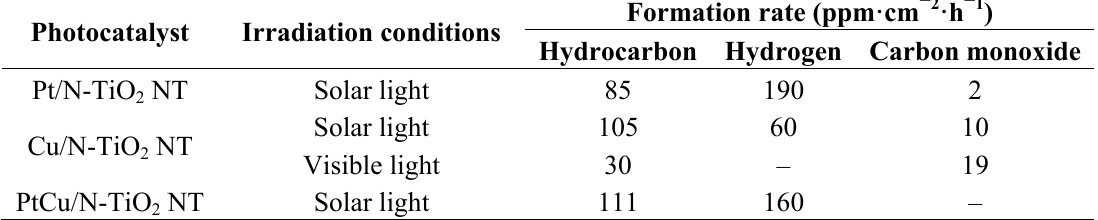
Table 4. Photocatalytic conversion of CO films loaded with single or binary platinum and copper co-catalysts under different irradiation conditions. The formation rate values have been estimated by interpolating data from reference